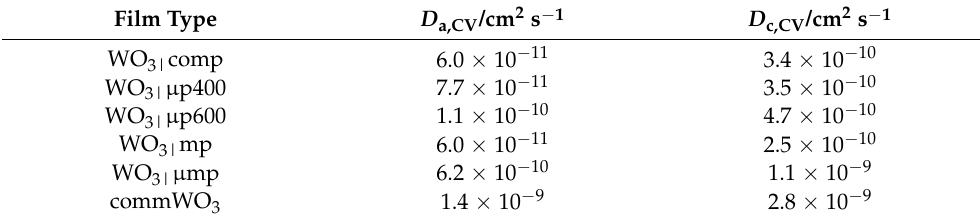
Table 7. Effective diffusion coefficients D a,CV and D c,CV determined from